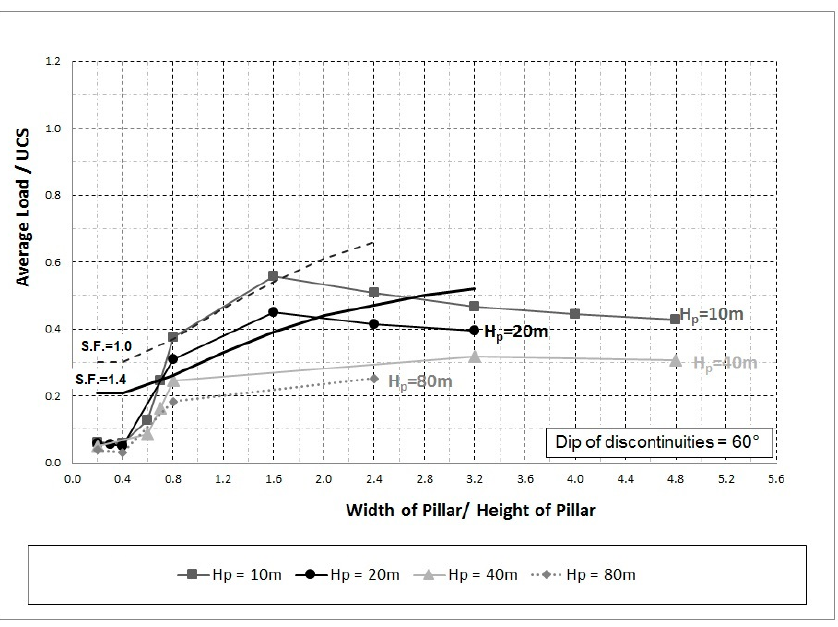
Figure 15. Failure envelopes considering the discontinuity dip angle for constant pillar height.